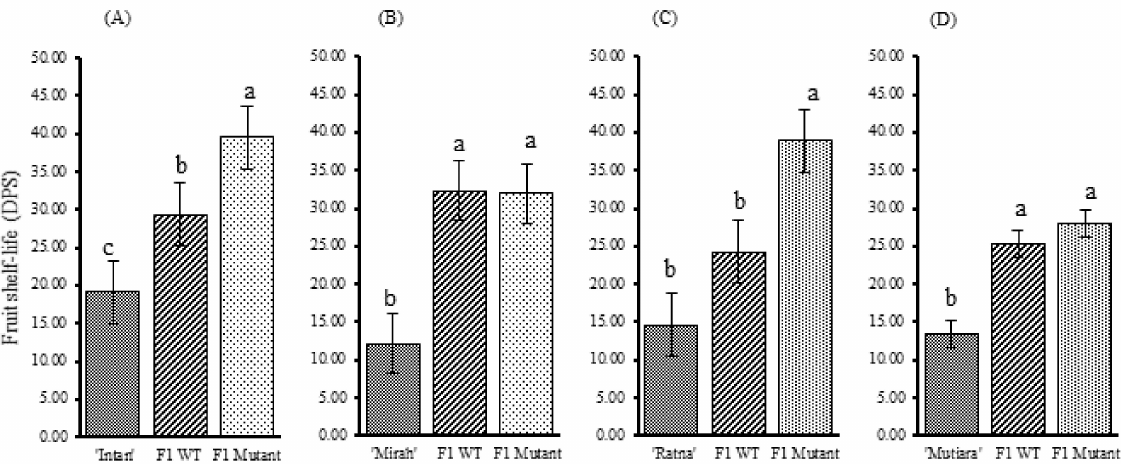
Figure 2. Shelf-life of F1 generation from four tropical tomato genetic backgrounds. ( A ) ‘Intan’, ‘Intan’ × ‘WT’, and ‘Intan’ × Sletr1-2 ; ( B ) ‘Mirah’, ‘Mirah’ × ‘WT’, and ‘Mirah’ × Sletr1-2 ; ( C ) ‘Ratna’, ‘Ratna’ × ‘WT’, and ‘Ratna’ × Sletr1-2 ; ( D ) ‘Mutiara’, ‘Mutiara’ × ‘WT’, and ‘Mutiara’ × Sletr1-2 ; Value is means ± SE ( n = 4 × 5). Letters denote statistically distinguishable values as assessed by the HSD Tukey test p < 0.05.